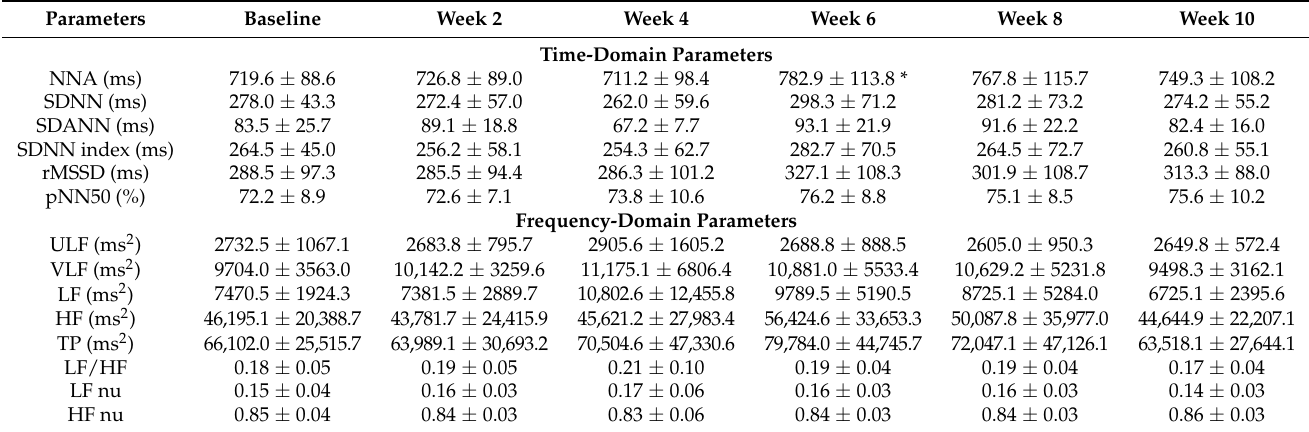
Table 1. Time- and frequency-domain parameters of heart rate variability (HRV) from seven dogs at baseline, weeks 2, 4, 6, 8, and